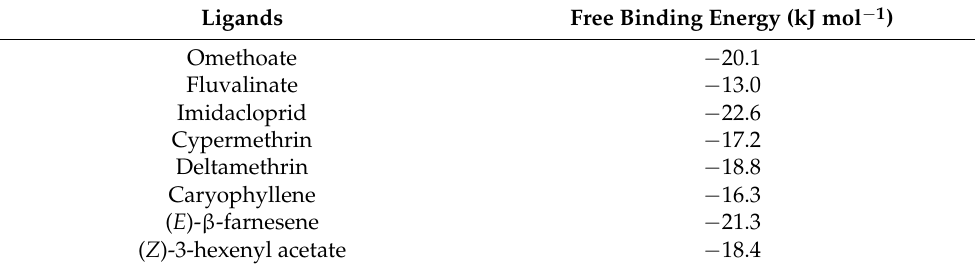
Table 3. Molecular docking scores of insecticides and semiochemicals against AgosCSP5.